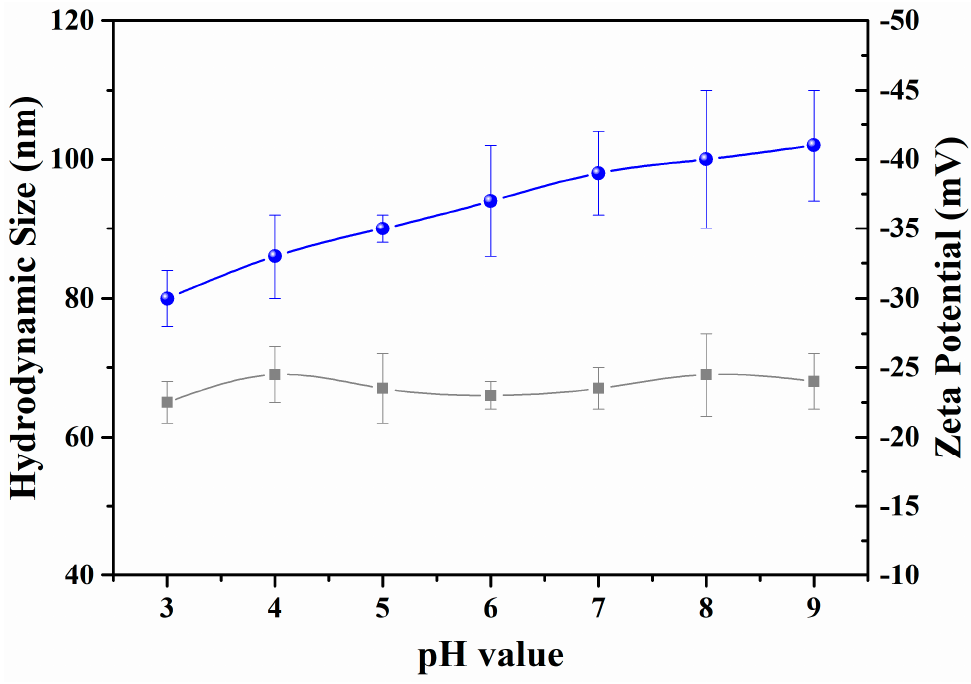
Figure 4. Variation of hydrodynamic size and zeta potential of LNPs with different pH values.